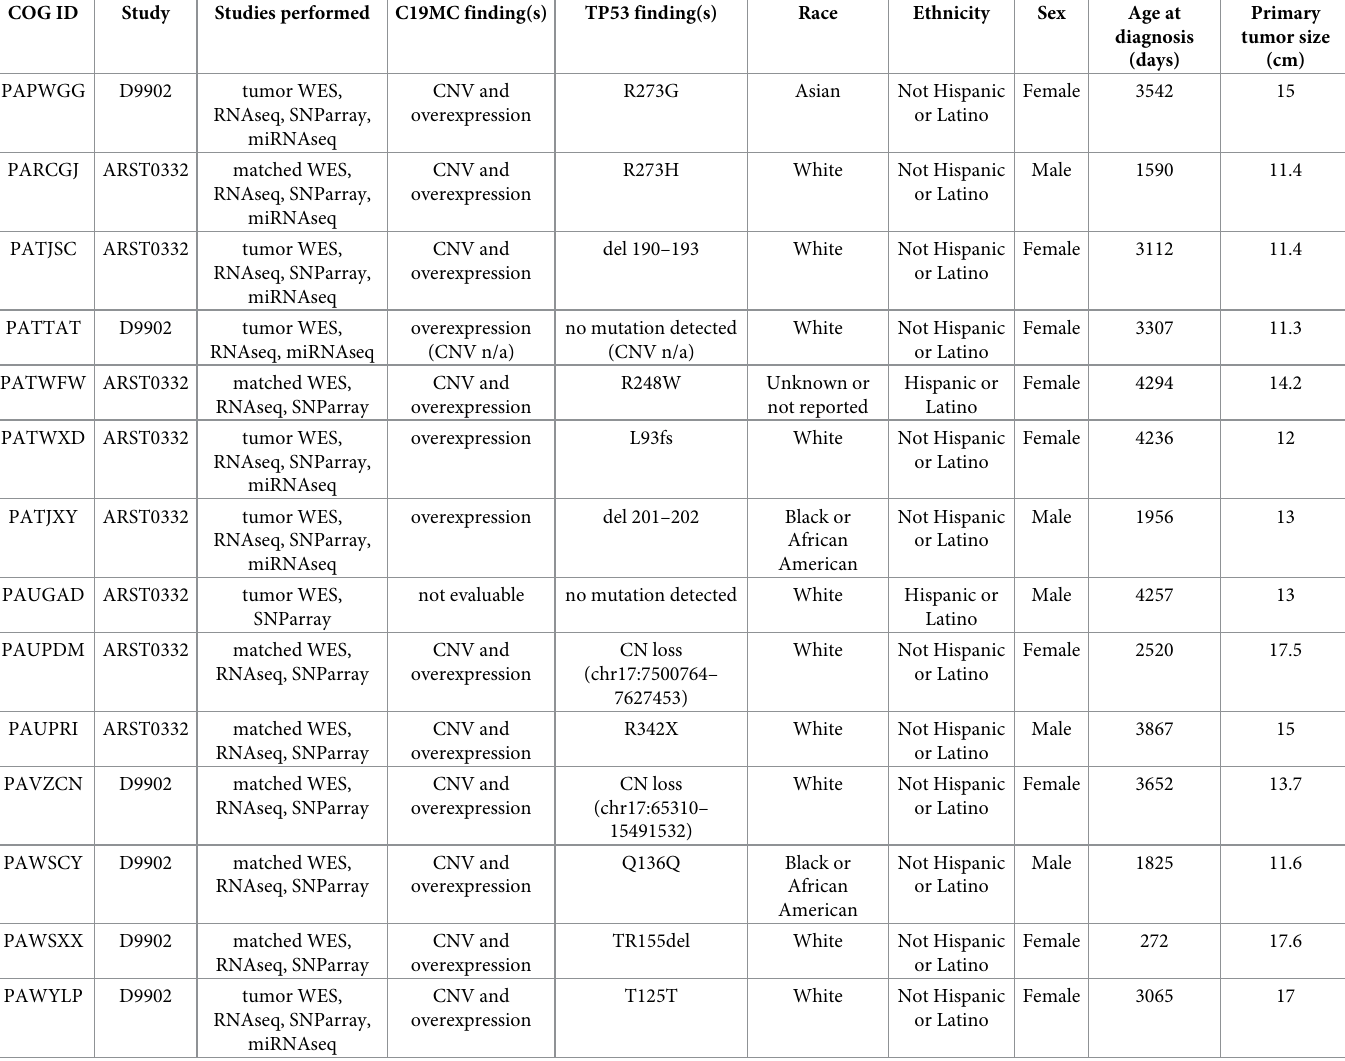
Table 1. Patient demographics and summary